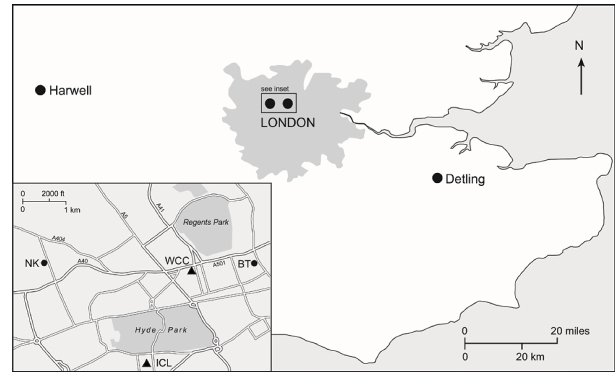
Figure 1. Map of the study area with the sampling sites (indicated with circles) and lidar locations (designated with triangles) indi- cated. Note for the start of the winter IOP the lidar operated from the Westminster City Council (WCC) building and then moved to Imperial College London (ICL). During the summer IOP the lidar operated from the North Kensington (NK)